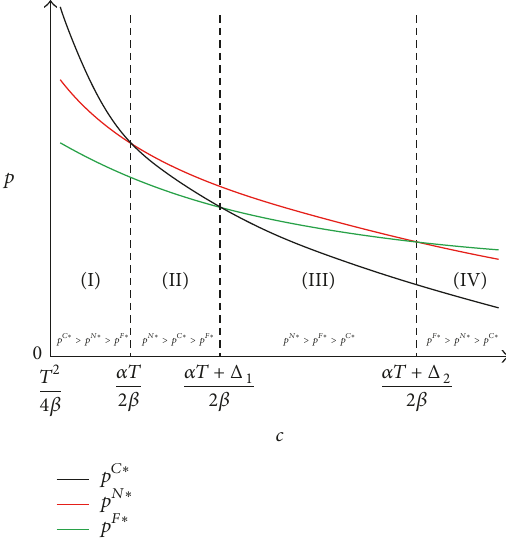
Figure 4: Different quantitative relations among 𝑝 𝐹∗ , 𝑝 𝑁∗ , and 𝑝 𝐶∗